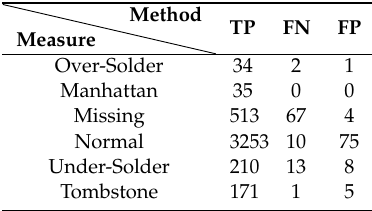
Table A3. Classification results of late-merge dual-stream CNN.